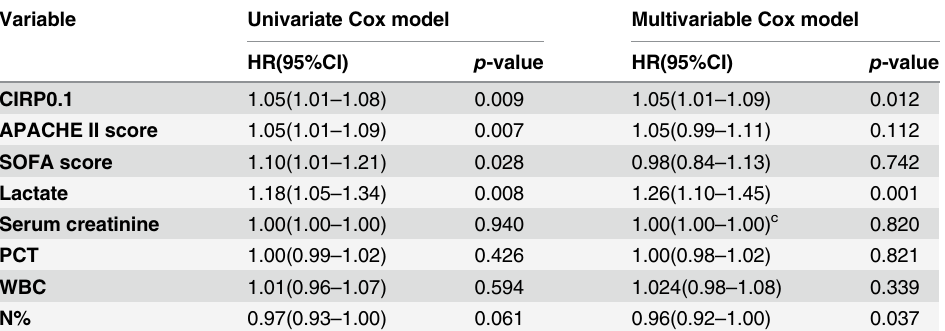
Table 4. Cox proportional hazards models for mortality prediction according to the biomarker levels and the severity